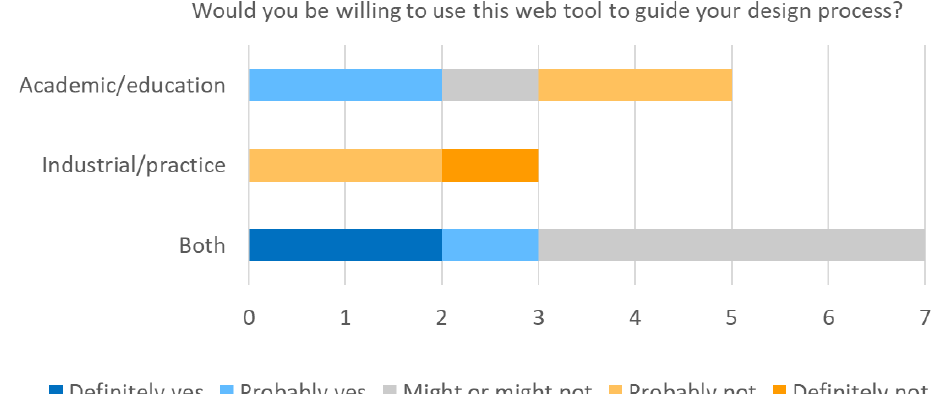
Figure 3. Perceived willingness to use PD Advisor.